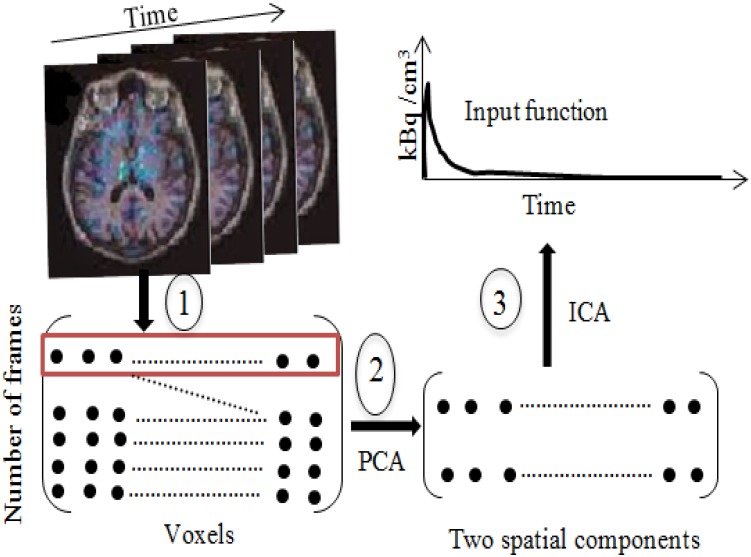
Illustration of the ICA algorithm process steps.(1) the dynamic PET images derived from sequential measurement of the radioactivity are re-arranged into 2D matrix, the first dimension refers to time acquisition fames and the second dimension refers to the spatial distribution. (2) the principal component analysis reduce matrix dimension in order to keep the most significant activity (if columns of a mixture have relatively similar TACs, then, the corresponding columns tends to be estimated as one components). (3) update the de-mixing matrix until found convergence in separation between the two components.